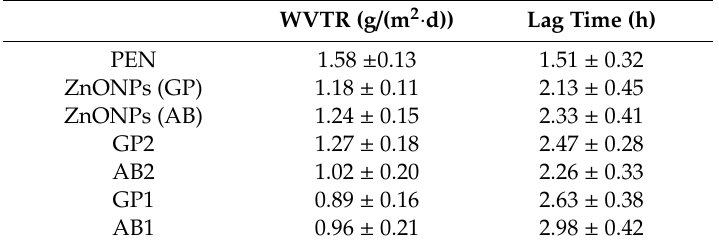
Table 3. Water vapor transmission rate (WVTR) and lag time of the coatings, determined through electrical calcium tests carried out in a climatic chamber at 38 ◦ C and 90% of relative